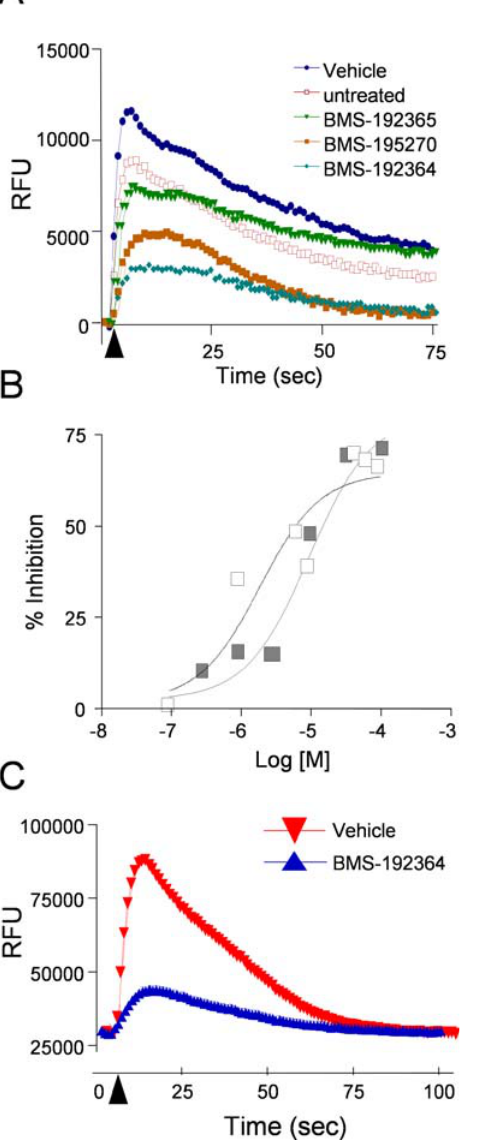
Figure 6. Effect of Compounds on Agonist-Induced Calcium Flux (A) The graph displays fluorescence intensity measurements for HEK293 cells preloaded with Fluo-4. Five baseline fluorescence measurements were taken prior to the injection of the muscarinic GPCR agonist carbachol. The timing of agonist addition is indicated by a black arrowhead. Measurements were performed in the presence of vehicle or the BMS small molecules indicated, at 100 l M. (B) Dose-response analysis for the effect of compounds on carbachol- stimulated calcium flux. White squares, BMS-195270; EC 50 2 l M. Black squares, BMS-192364; EC 50 9 l M. (C) The graph displays fluorescence intensity measurements for primary smooth muscle cells preloaded with Fluo-4. Five baseline fluorescence measurements were taken prior to the injection of the GPCR agonist histamine. The timing of agonist addition is indicated by a black arrowhead. Measurements were performed in the presence of vehicle or BMS-192364 (100 l M). DOI: